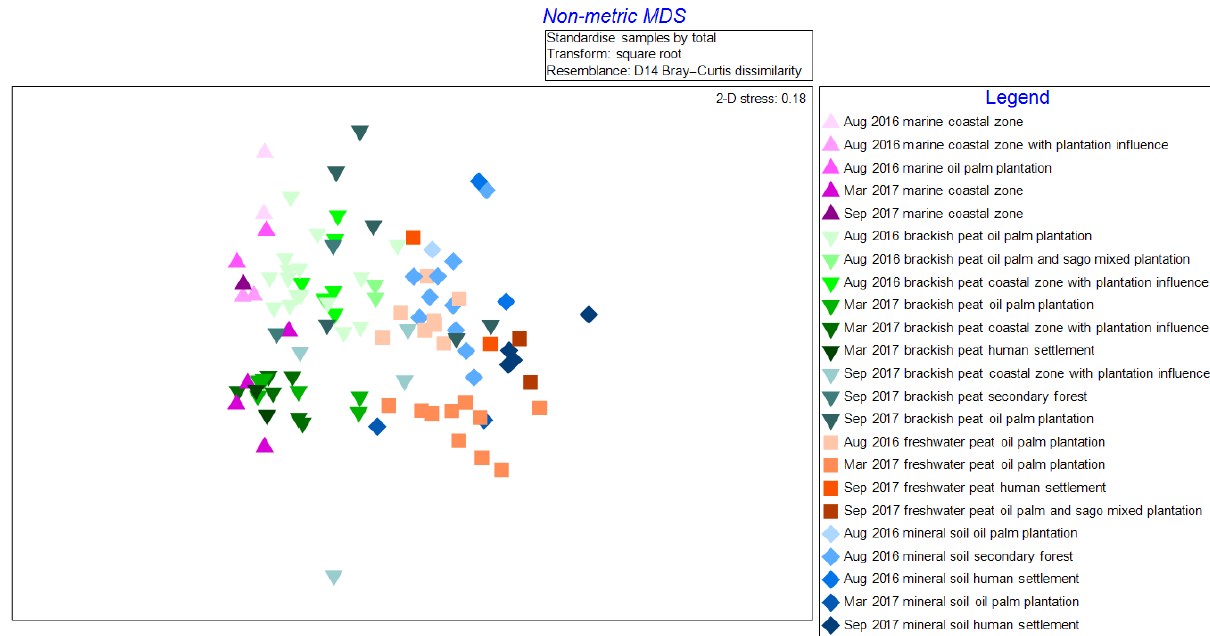
Figure 2. Non-metric multi-dimensional scaling (NMDS) graph of samples according to cruise, source type and land